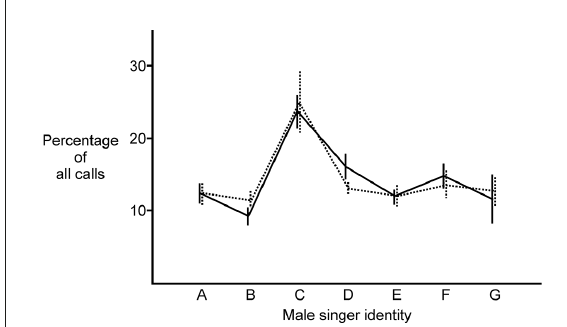
FIGURE4 NC lesioned females were still able to identify the songs of individual males. After lesioning NC, there was no significant change in the distribution of their song preferences for specific males (two sample Kolmogorov-Smirnov test, KS statistic = 0.08, p = 0.92, N = 11 birds; solid line indicates the average percentage of calls for experimental birds in Phase 1; dotted line indicates the average percentage of calls for the same set of experimental birds in Phase 2; heterospecific song is represented by letter G). This absence of change between the first and second behavioral tests was also evident for control birds and sham birds (detailed in “Results”